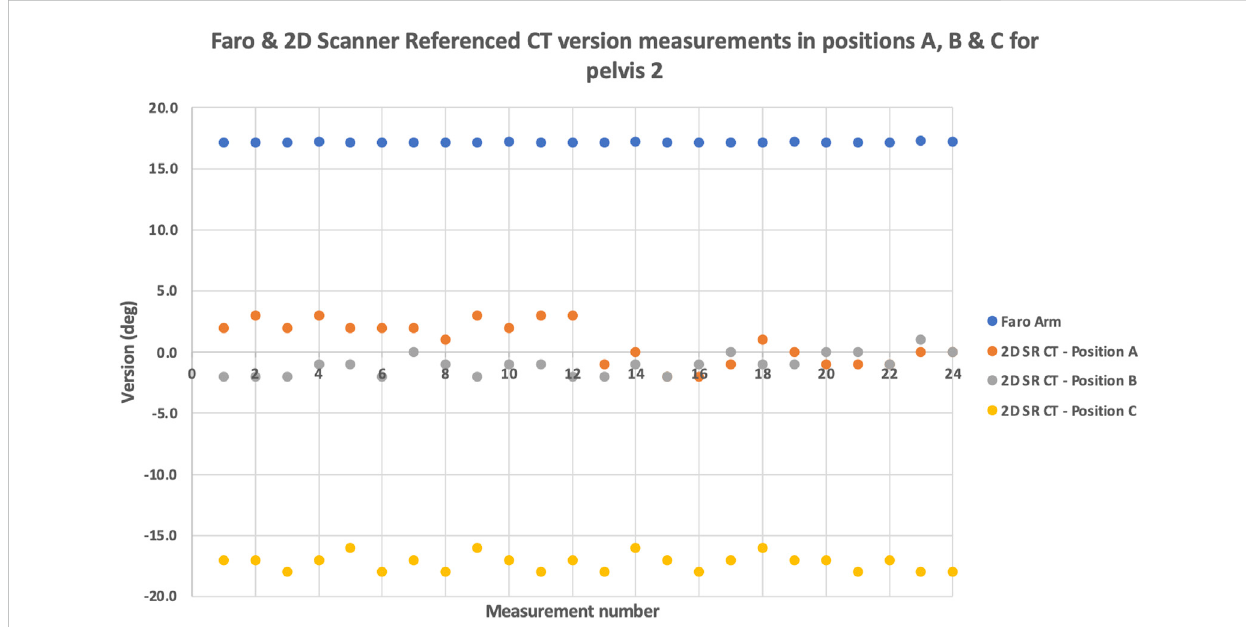
FIGURE 4 The effect of pelvic orientation: XY scatter plot of the repeated version angle measurements using the digitising arm and 2D SR CT for pelvis 2. The measurements were obtained at different pelvic orientations (A,B,C)